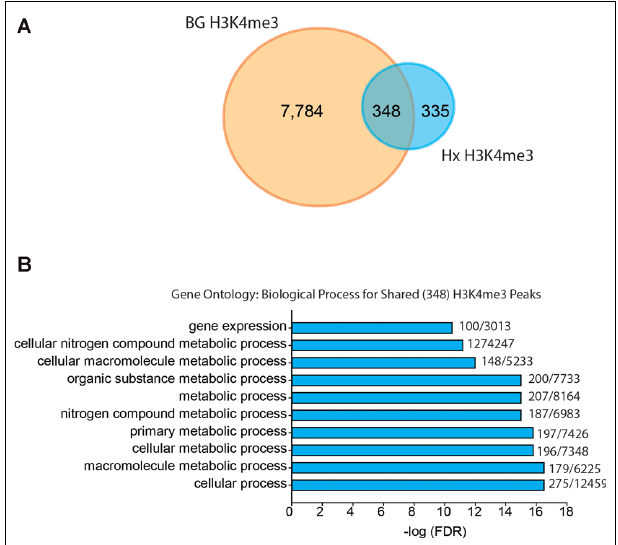
FIGURE 6 | Hypoxia-induced H3K4me3 enrichment occurs in distinct genes from those primed by β -glucan. (A) Venn diagram comparing numbers of similar and unique genes with H3K4me3 enrichment after BG or Hx priming. (B) Gene ontology for biological process was performed for genes enriched with H3K4me3 at the transcription start site shared between Hx and BG priming. H3K4me3 peaks were called using Nx control or RPMI control as background for Hx and BG priming, respectively. Numbers at the end of each bar represent observed genes/expected genes in each category. Results are derived from n = 3 biological